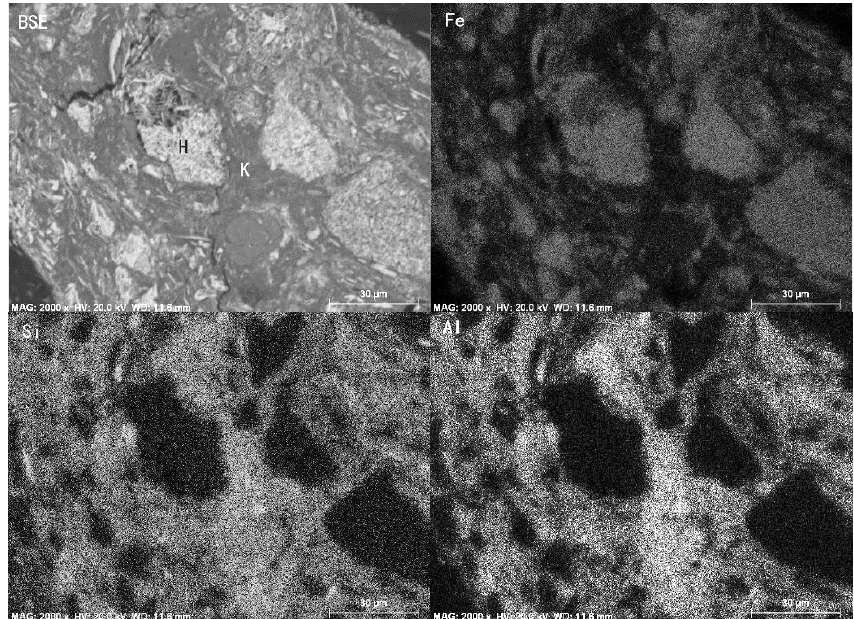
Figure 2. Representative SEM ‐ BSE micrographs of high ‐ aluminum hematite ‐ limonite ore. (BSE, Back Scattered Electron Imaging; H, hematite; K, kaolinite).